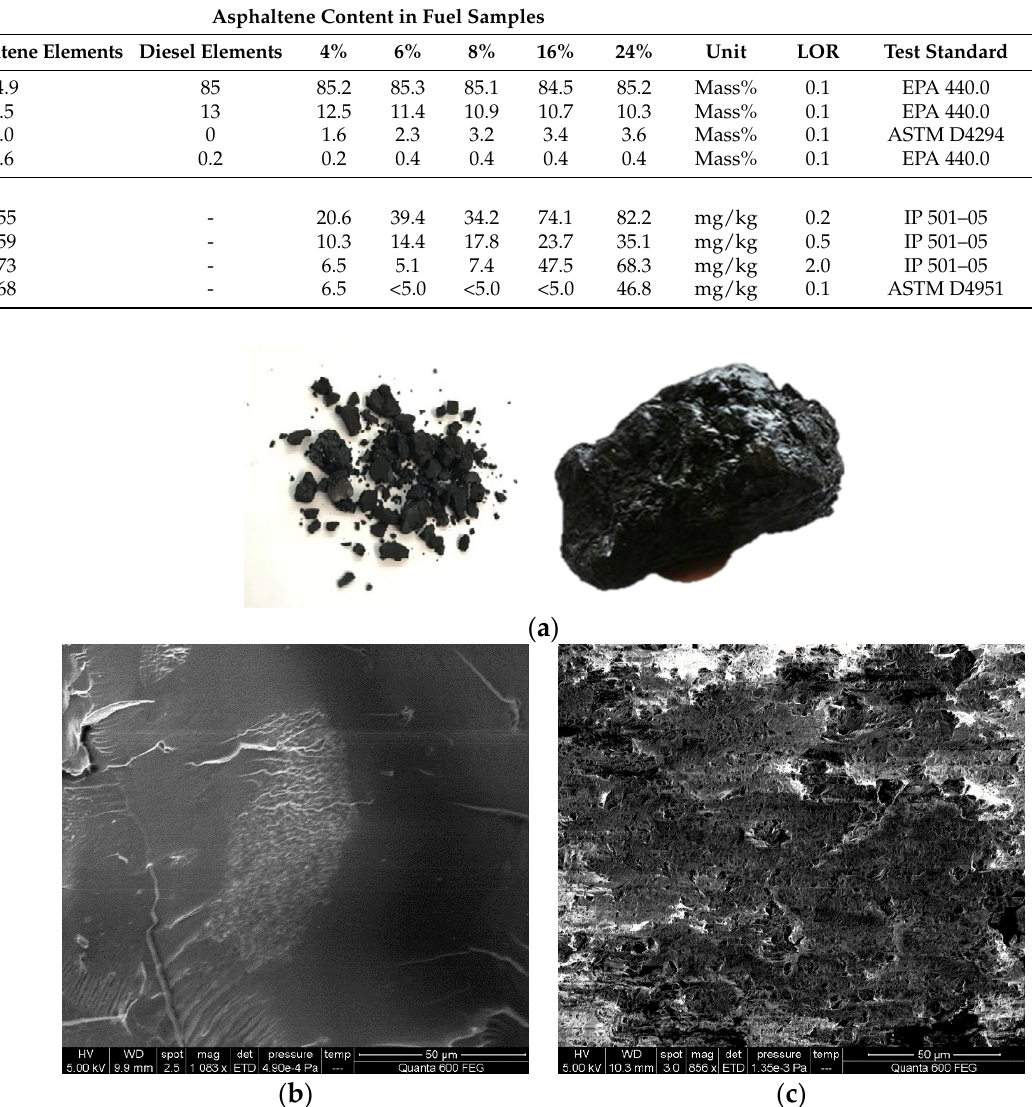
Table 2. Element compositions of the fuel samples.